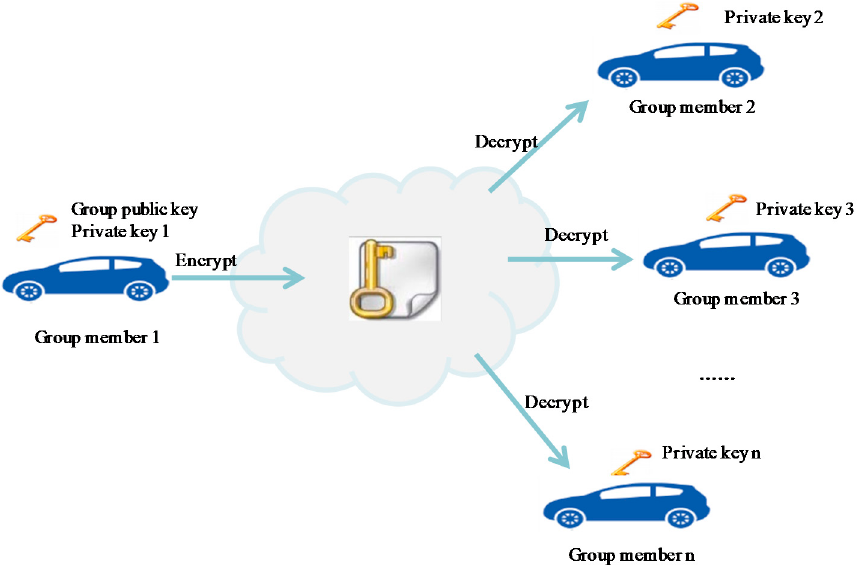
Figure 3. The proposed key management method for secure V2X group communication.